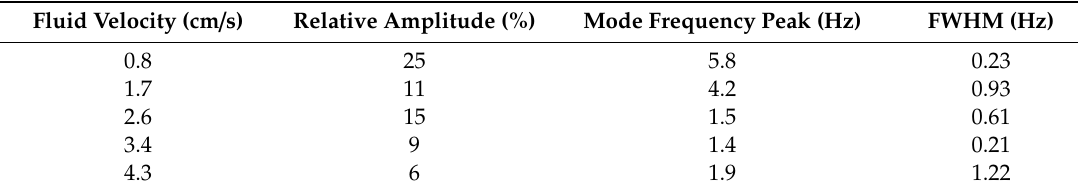
Table 1. Frequency analysis of the first mode associated to the current measurement at di ff erent mean velocities in the case of DIW.